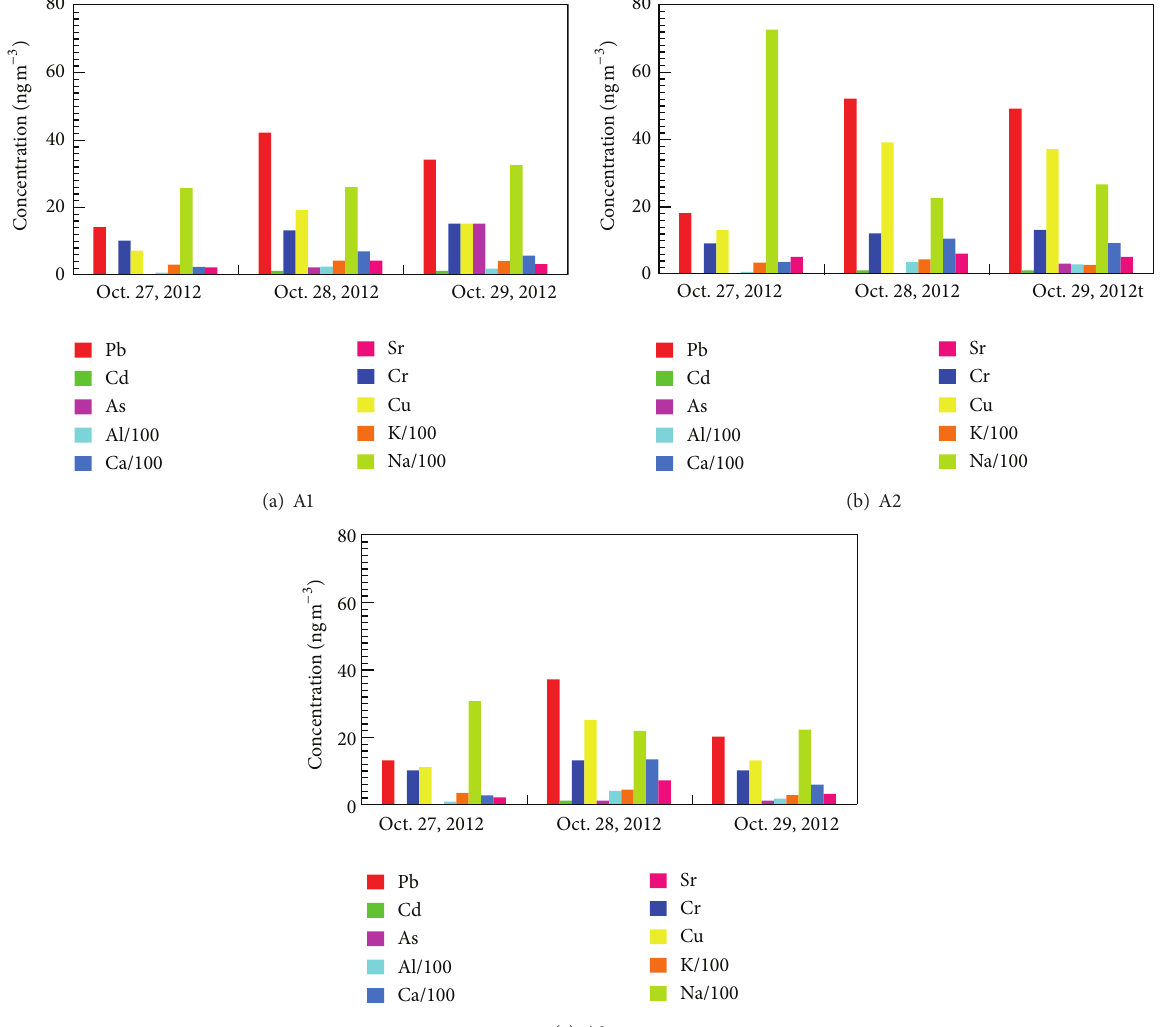
samples can be calculated using the Al concentration (8%, [18]). The fractions of mineral dust during the three days (Oct. 27–29) were 2.1, 8.4, and 8.4% of the total PM 10